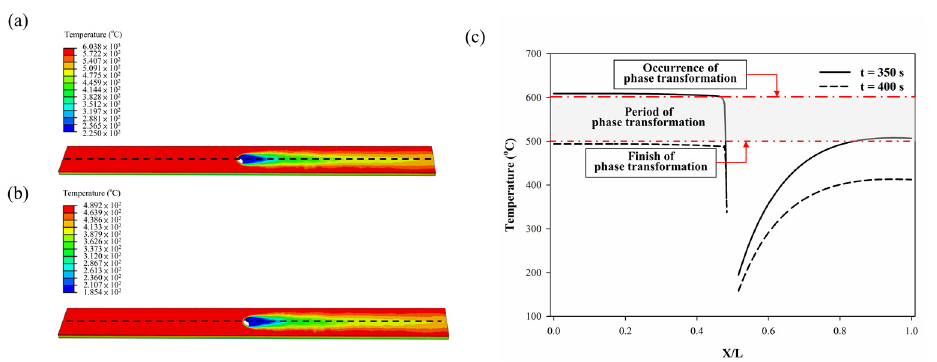
Figure 6. Outlined photo for illustrating the overall temperature distribution ( a ) at 350 s, ( b ) 400 s, and ( c ) the temperature distribution along the dashed line at a different time.